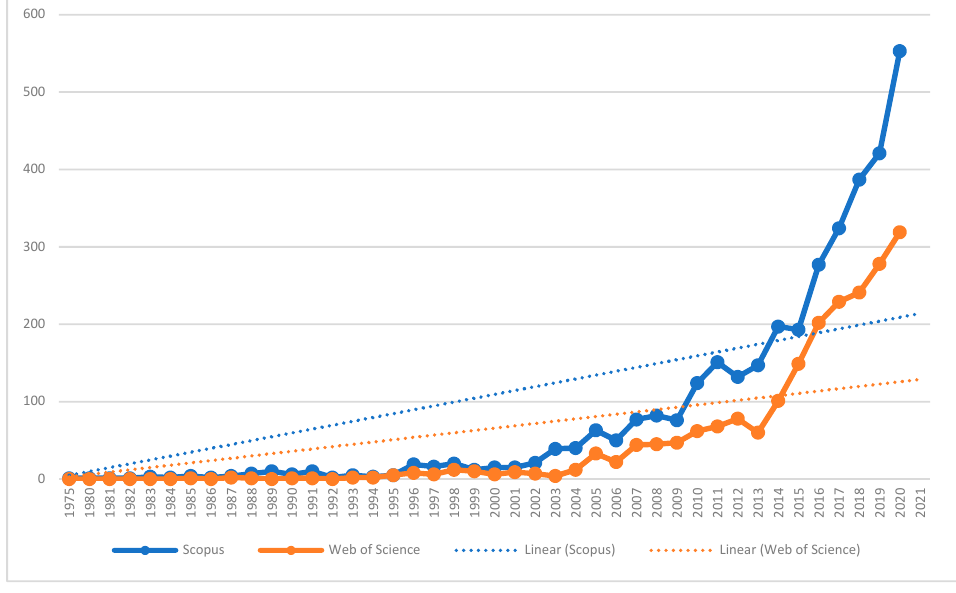
Figure 2. Evolution of studies involving innovation environment over the years.